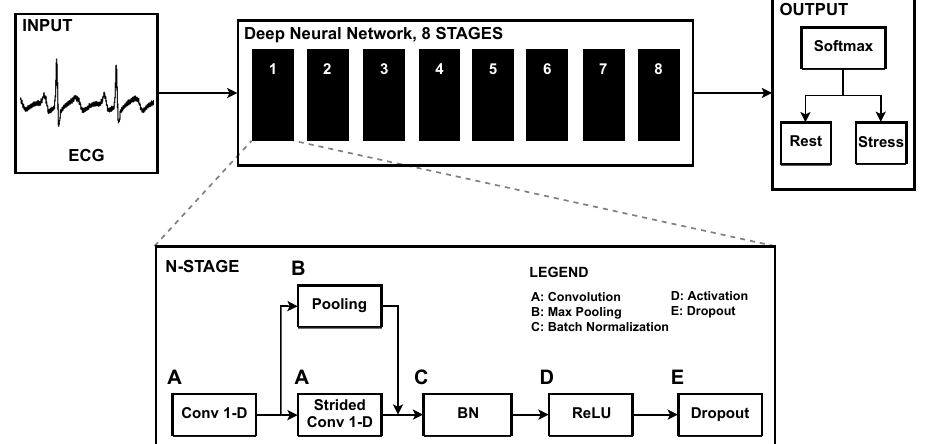
Figure 2. Deep neural network architecture and the components of each stage. Raw ECG signals are provided into the input layer. The successive stages extract features from an output of a previous stage. After the last stage, a softmax classifier performs a binary classification between the rest and stress. Table 3. List of operations and hyperparameters used in each stage.